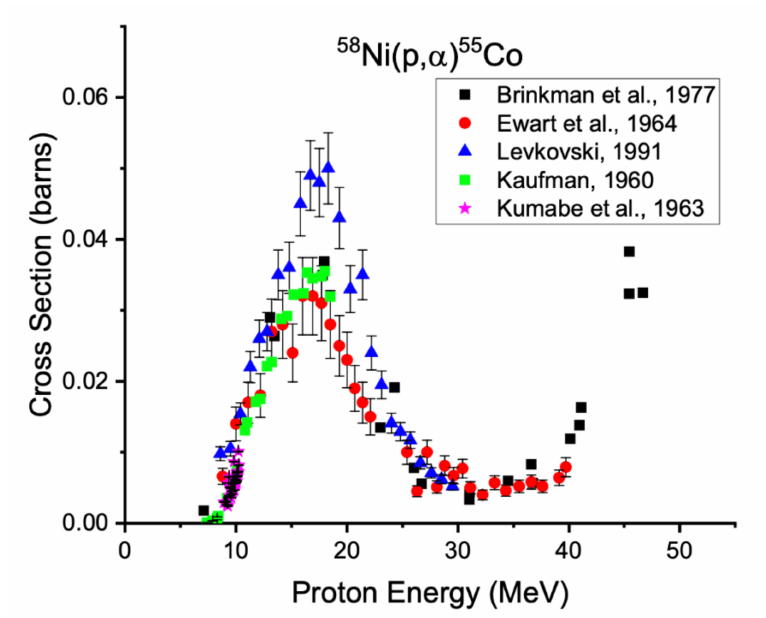
Figure 9. Excitation functions for production of cobalt-55 from nickel-58